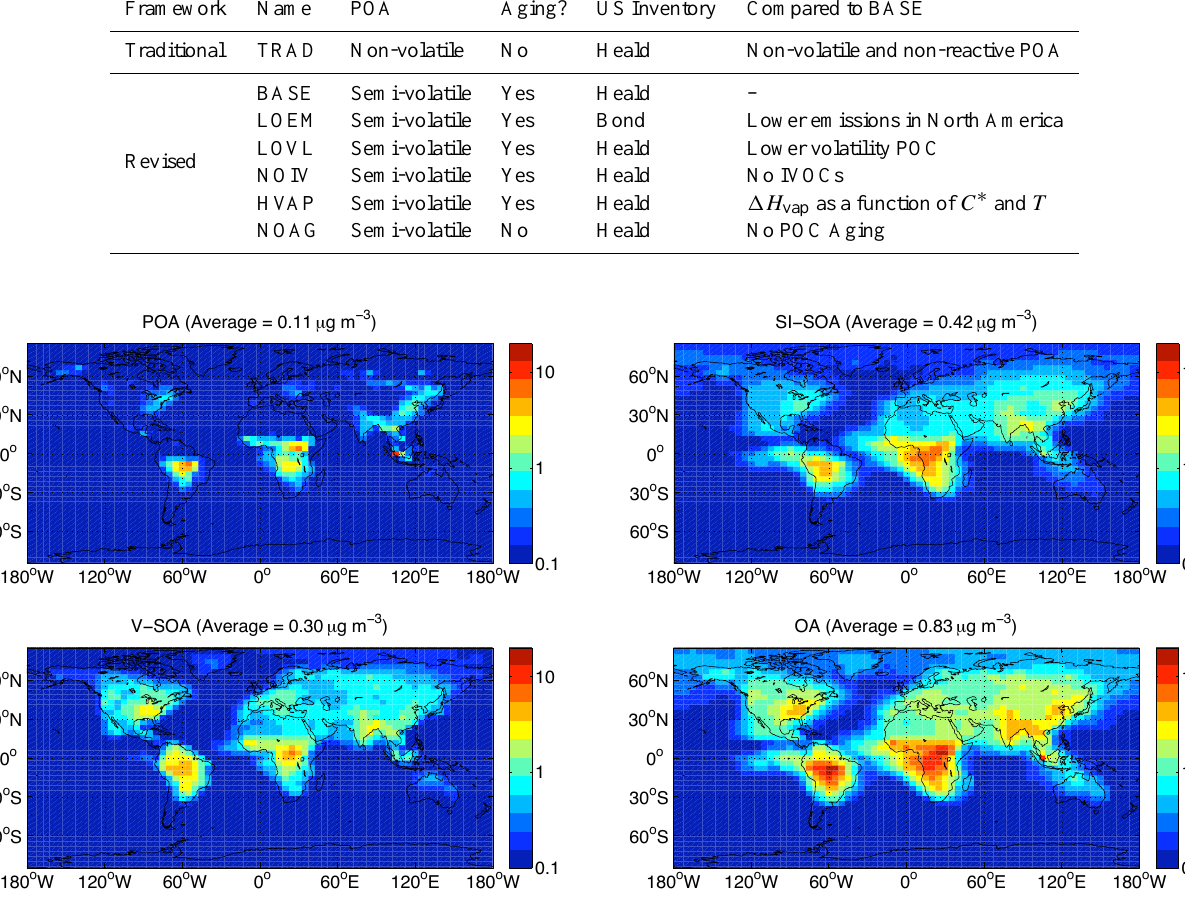
Fig. 4. Annual-average surface mass concentrations of POA, SI-SOA, V-SOA and total OA in µgm − 3 for BASE simulation. Area-weighted surface concentrations are shown in Fig. 5 : Annual-average surface concentrations of POA, SI-SOA, V-SOA and total OA in 3 for BASE simulation. Area-weighted surface concentrations are shown in parentheses. µg m −